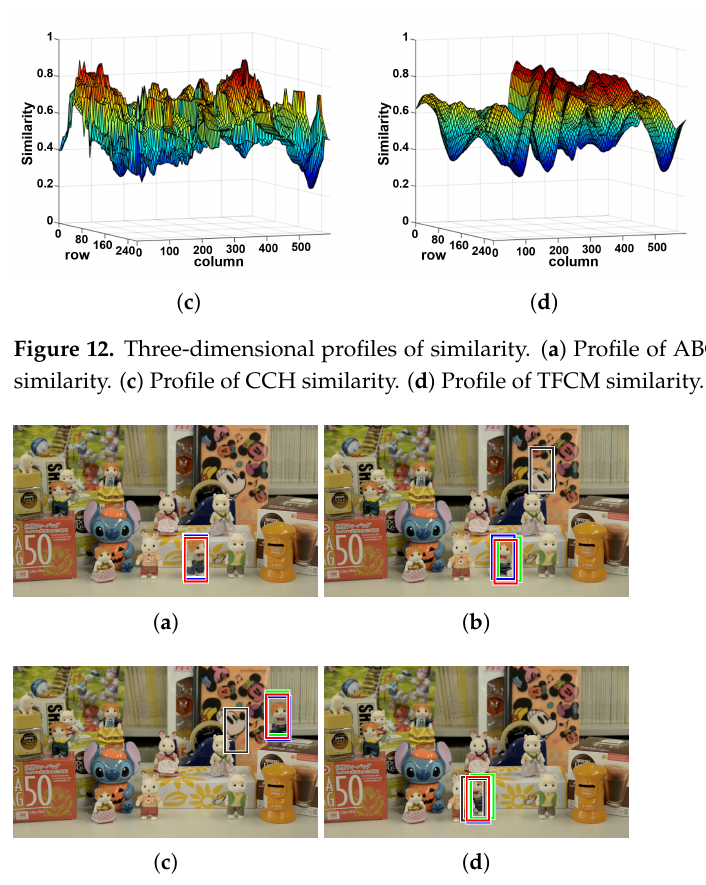
Figure 13. Search under rotation, deformation, scaling, and occlusion by ABC, CI, CCH, and TFCM where the red, blue, green, and black bounding boxes represent the matching results of four ap- proaches, respectively. ( a ) Rotation. ( b ) Deformation. ( c ) Scaling. ( d )